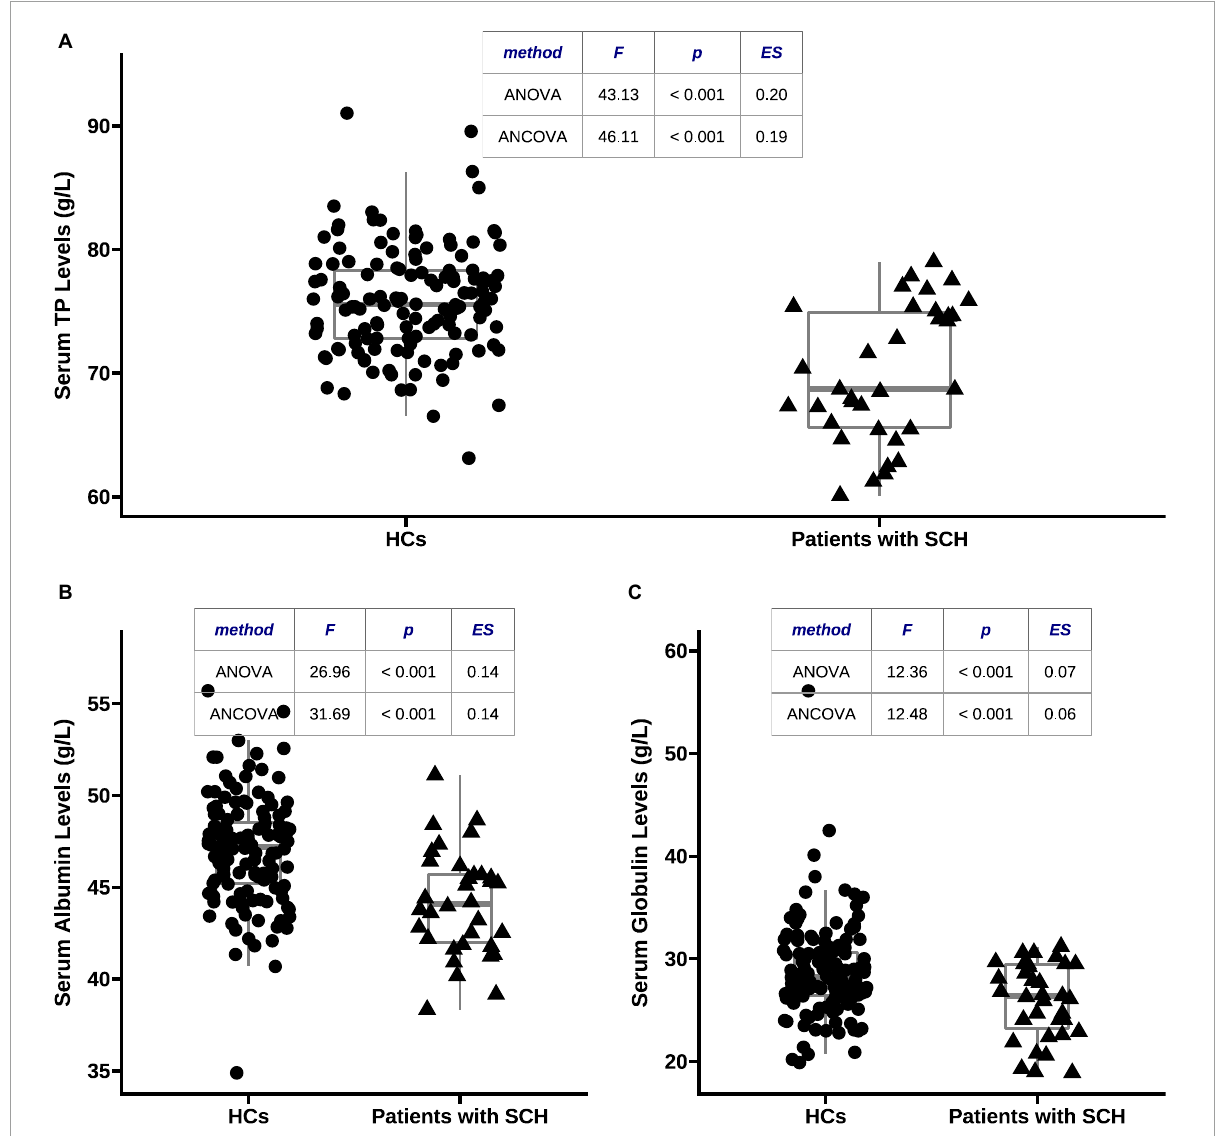
FIGURE1 Comparisons of serum total protein (TP), albumin, and globulin levels between patients with schizophrenia (SCH) and healthy controls (HCs). (A) Serum TP concentrations were markedly lower in patients with SCH than that in HCs after adjusting for covariates (70.01 ± 5.52 vs. 75.84 ± 4.38, F = 46.11, p < 0.001, η 2 = 0.19); (B) serum albumin concentrations were markedly lower in patients with SCH than that in HCs after adjusting for covariates (44.14 ± 2.87 vs. 47.01 ± 2.90, F = 31.69, p < 0.001, η 2 = 0.14); and (C) serum globulin concentrations were markedly lower in patients with SCH than that in HCs after adjusting for covariates (25.88 ± 3.67 vs. 28.83 ± 4.54, F = 12.48, p < 0.001, η 2 = 0.06). TP, total protein; HCs, healthy controls; SCH, schizophrenia; ANCOVA, analysis of covariance; ANOVA, analysis of variance.